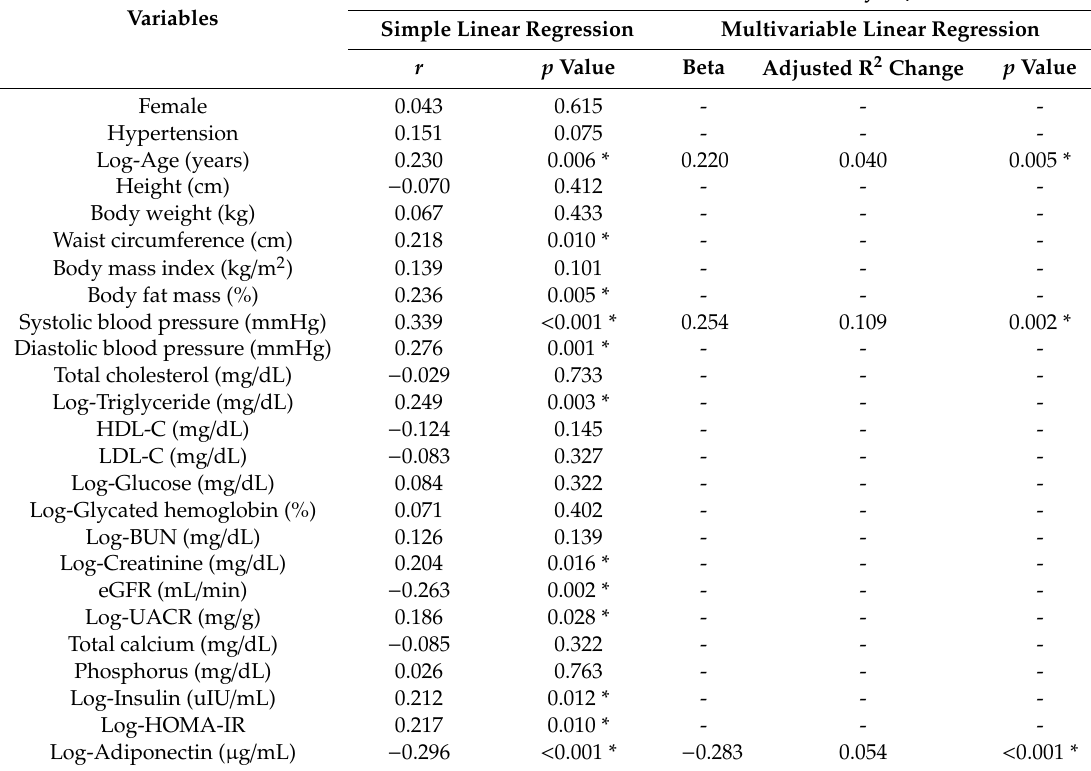
Table 3. Correlation between carotid–femoral pulse wave velocity and clinical variables among type 2 diabetes mellitus